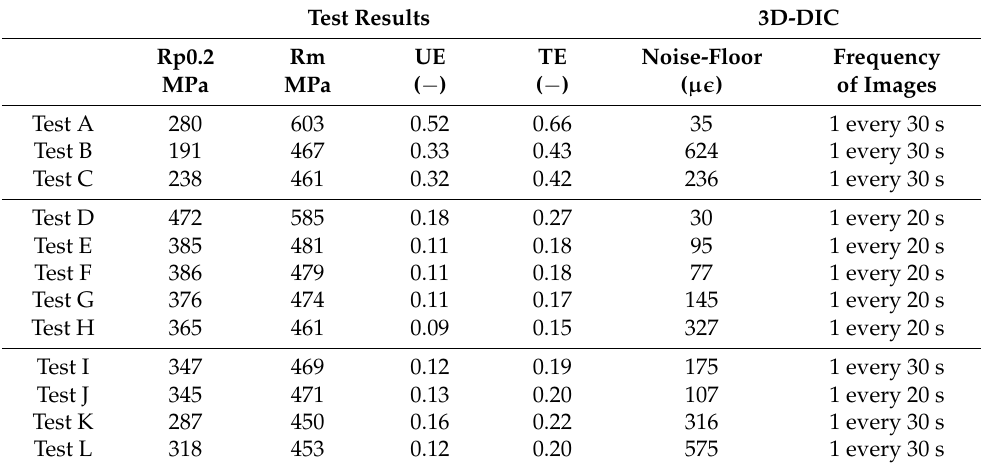
Table 5. Tests results, noise-floor and time resolution for all tests presented in this